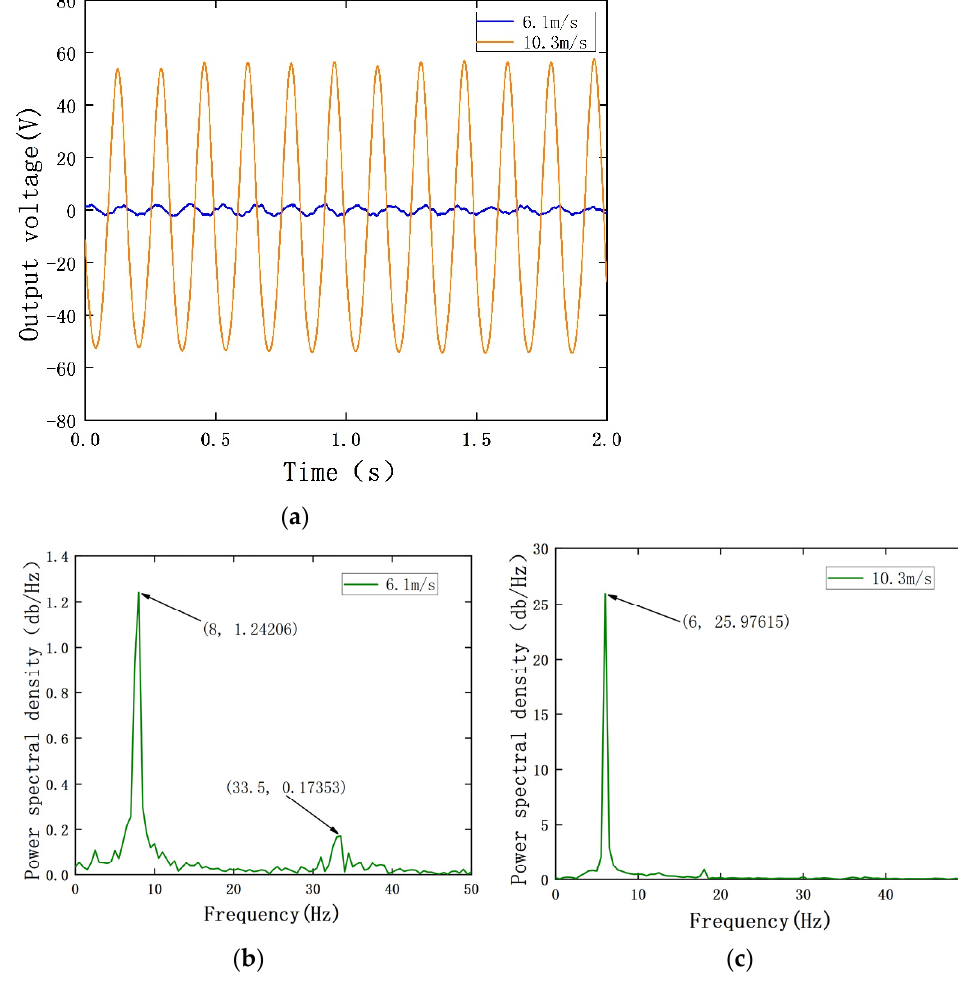
Figure 4. The output performance of the PEH under different wind speeds: ( a ) the PEH output power at different wind speeds; ( b ) output power spectrum density of the PEH at 6.1 m/s; ( c ) output power spectrum density of the PEH at 10.3 m/s.